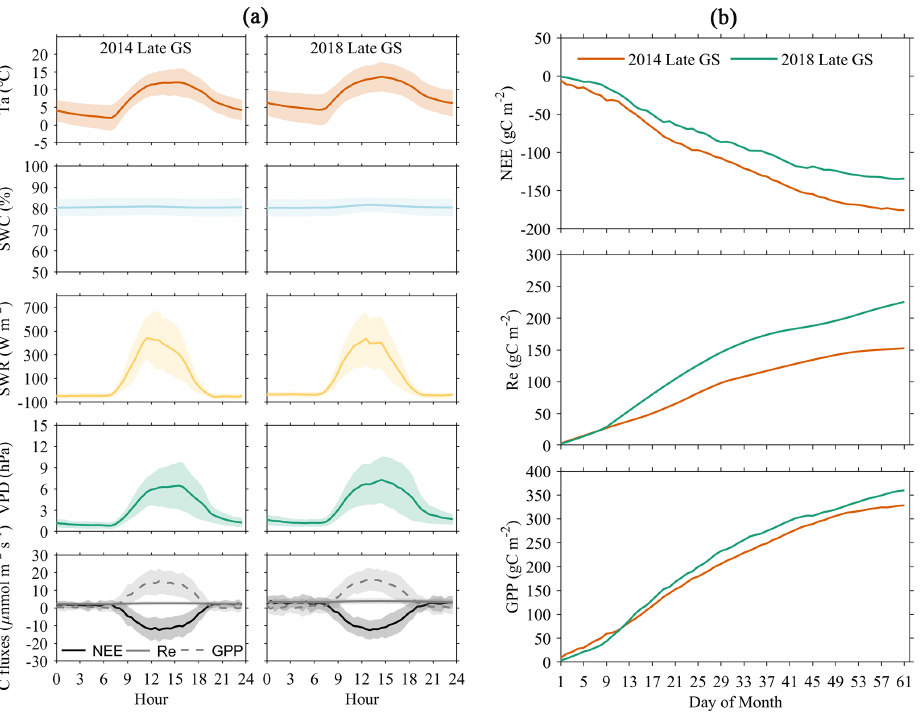
Figure 7. (a) Comparisons of the diurnal variations of environmental drivers (Ta, SWC, Rn, and VPD) and C fluxes (NEE, Re, and GPP) be- tween the late growing season of 2014 and 2018. The shading represents the mean ± standard deviation of the presented variables. (b) Com- parisons of the daily accumulated C fluxes (NEE, Re, and GPP) between the late growing season of 2014 and 2018. Note that late GS represents late (August–September) growing